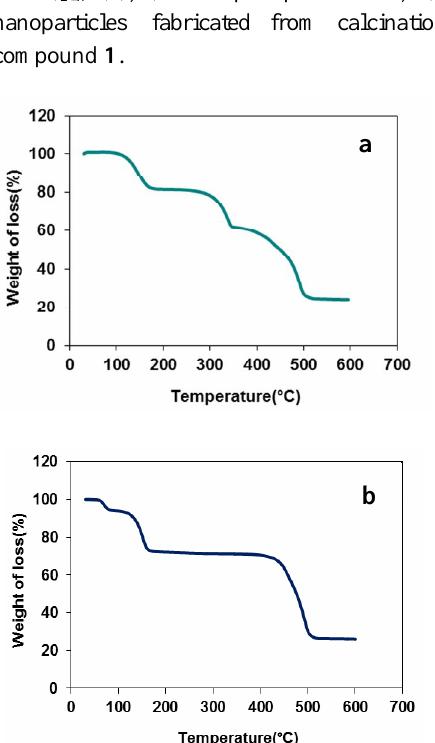
Fig. 3. Thermal behaviour of a) [Zn